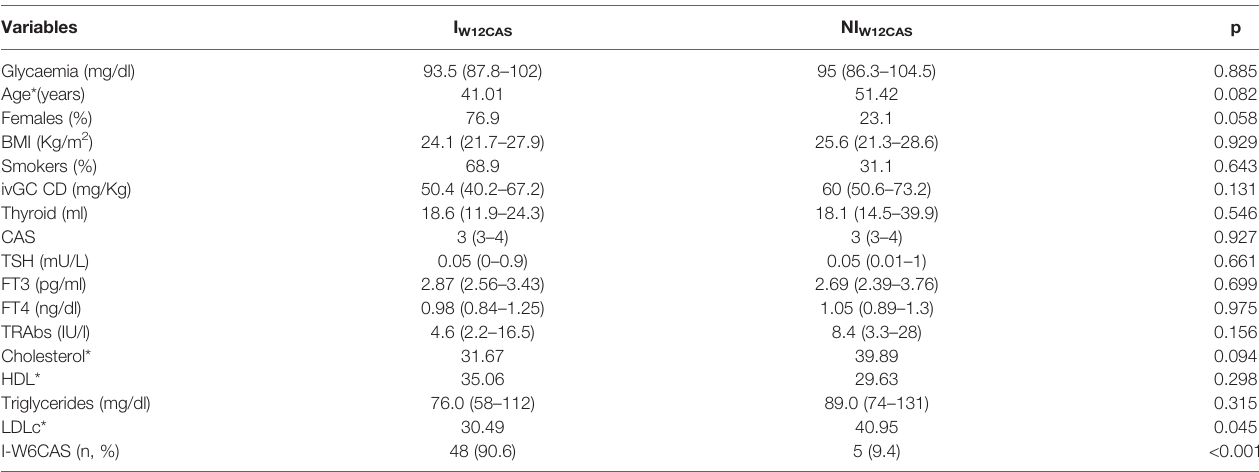
TABLE 2 | Univariate analysis for W12CAS outcome. Variables